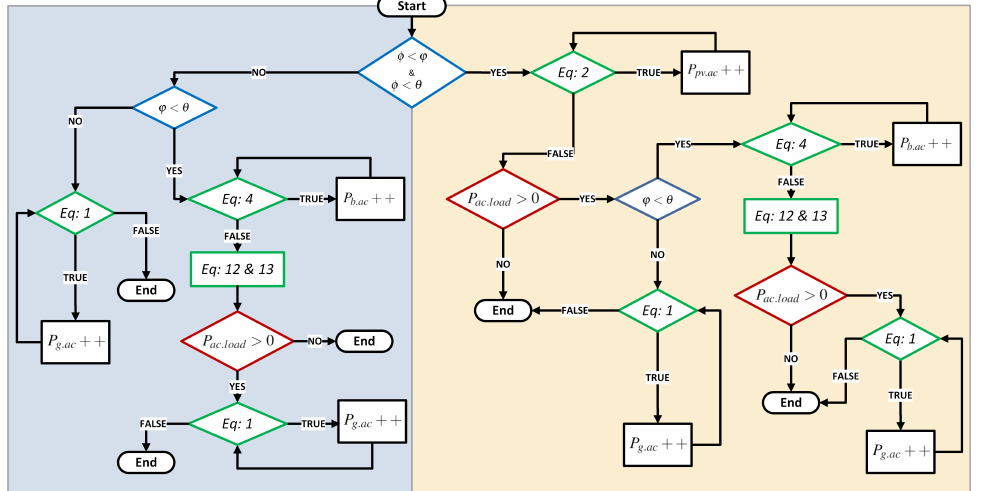
Figure 6. Case I flow